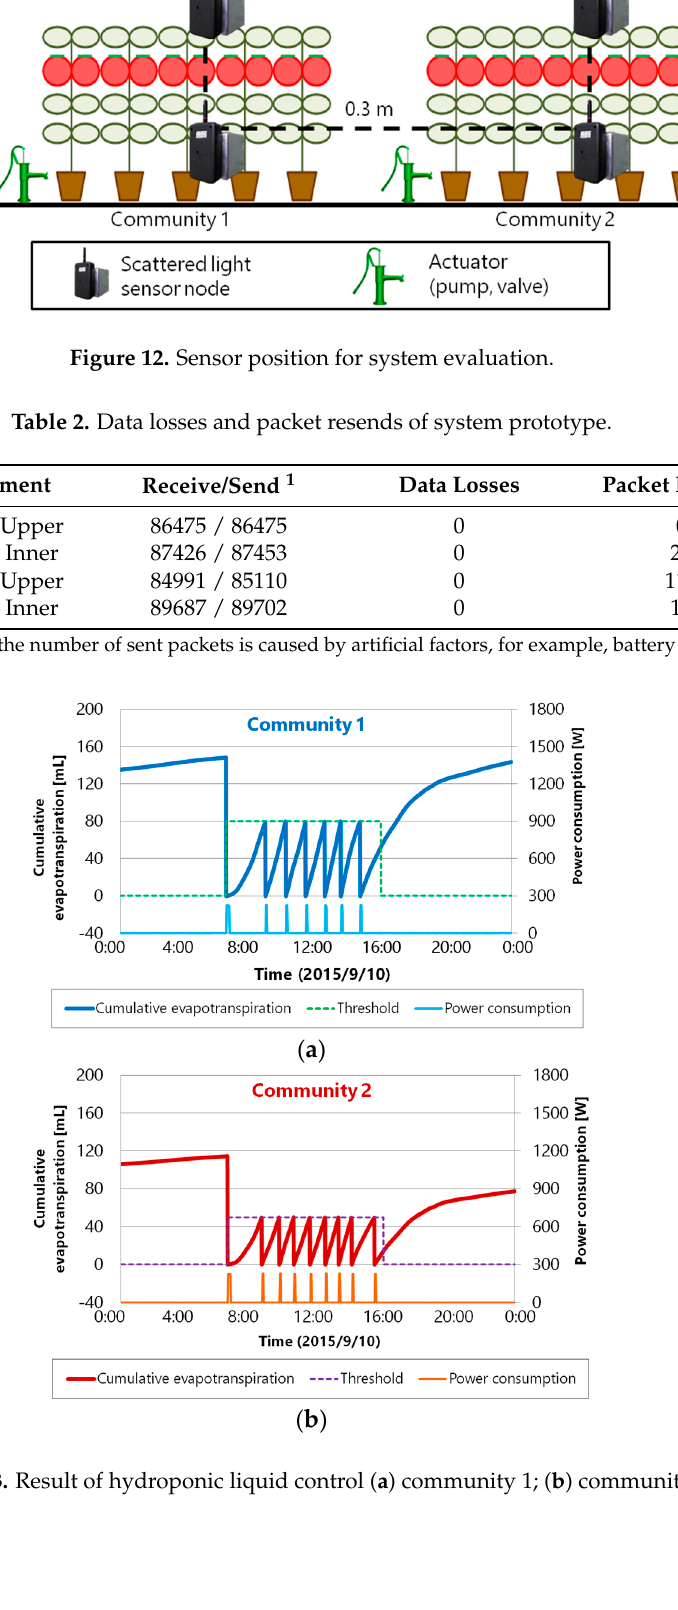
Table 2. Data losses and packet resends of system prototype.